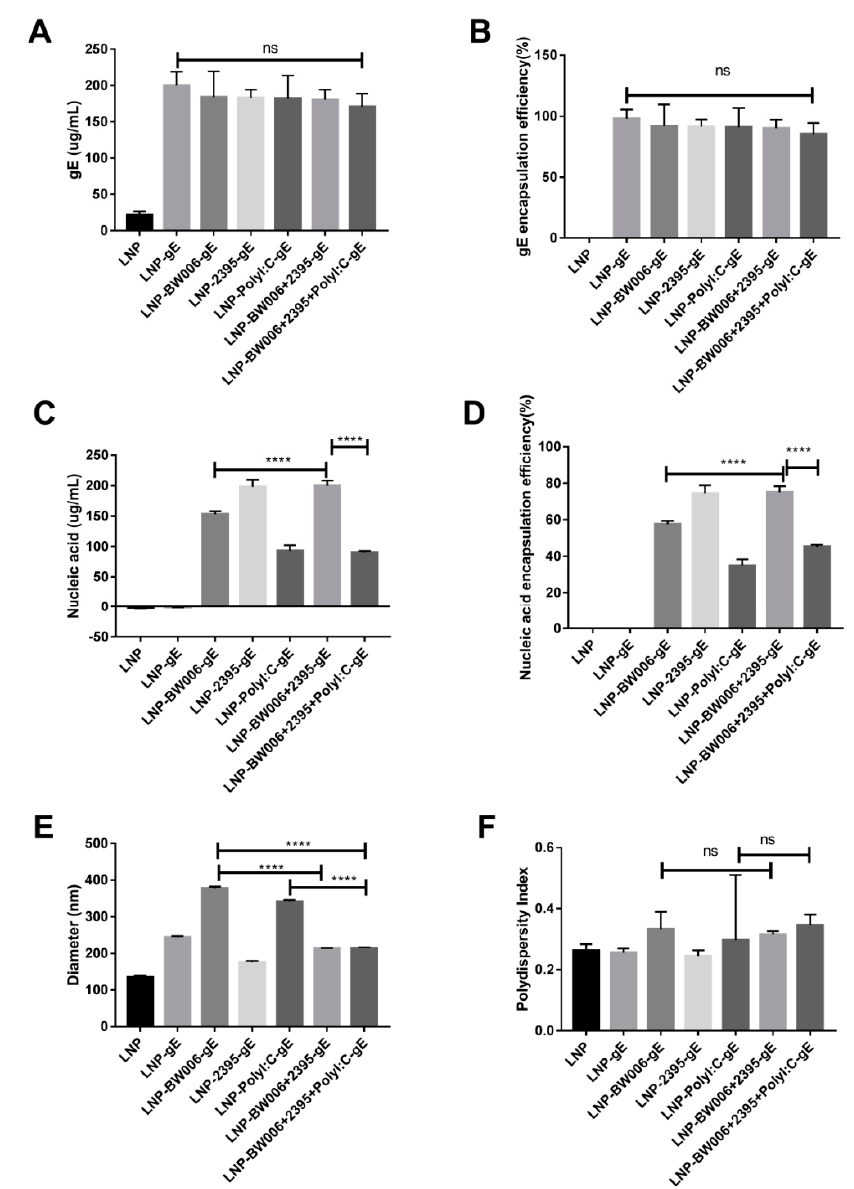
Figure 1. Characterization of LNP vaccines. ( A ) gE concentration; ( B ) gE encapsulation efficiency; ( C ) Nucleic acid immunostimulator concentration; ( D ) Nucleic acid immunostimulator encapsulation efficiency; ( E ) Diameters tested by a size analyzer; ( F ) Polydispersity index of LNPs. **** p < 0.0001. ns, no significant difference.